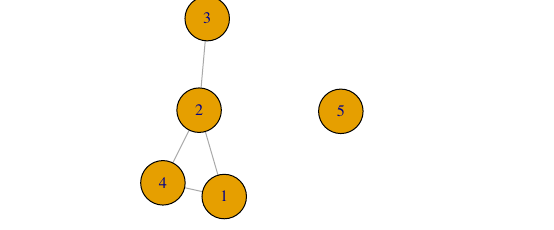
FIG. 1. An undirected toy network, for illustration purposes only. If an interaction occurred, the edge exists regardless of which node initiated the